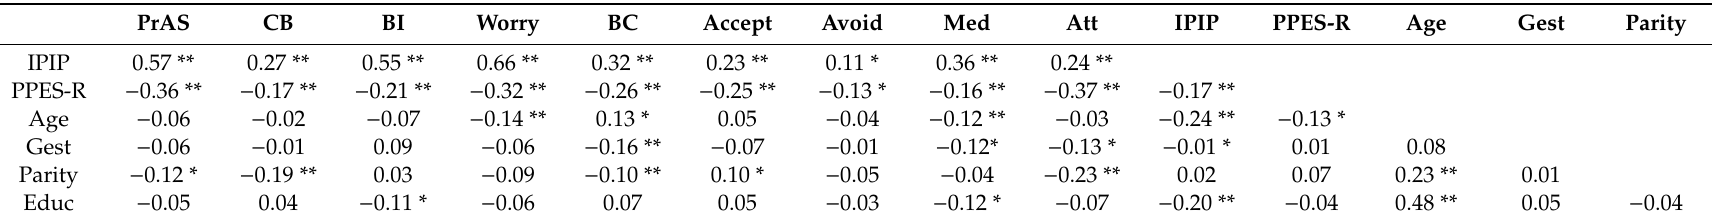
Table 3. Correlations between the pregnancy-related anxiety scale (PrAS), PPES-R, international personality item pool (IPIP) and demographic